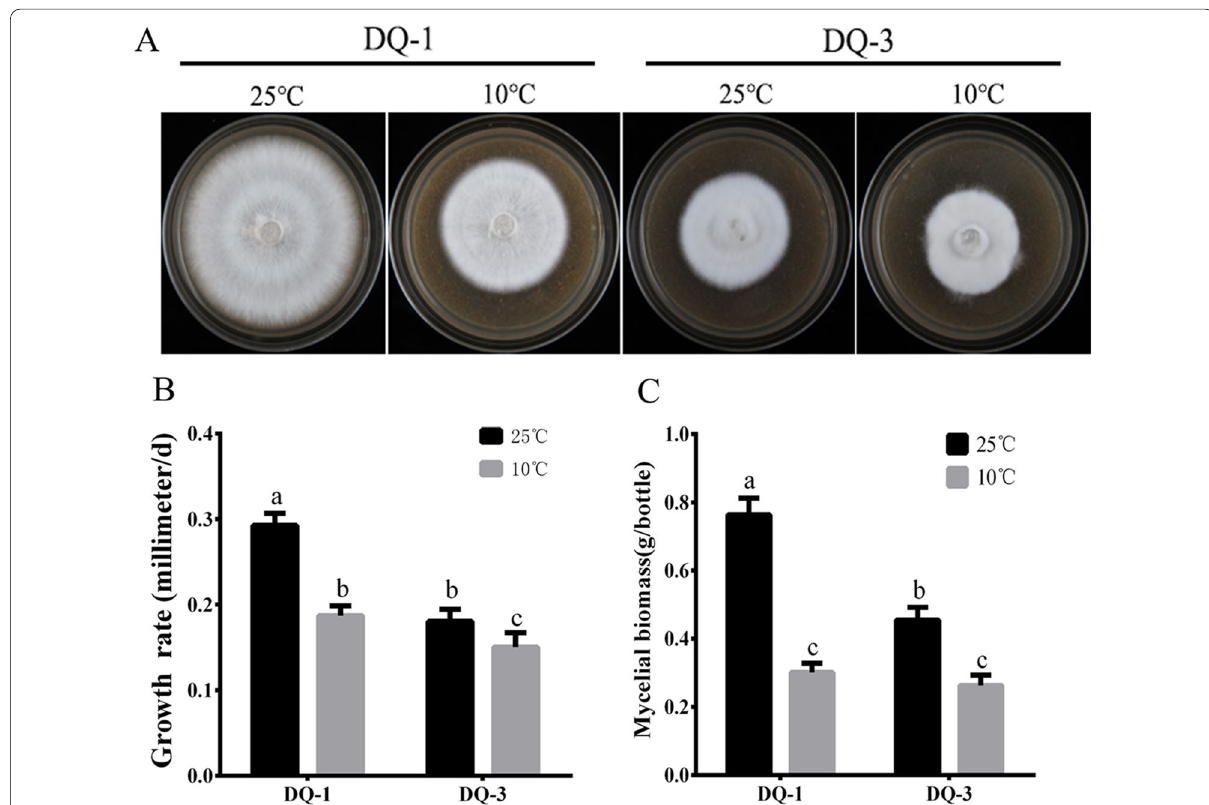
Fig. 1 Physiological performance of the S. rugosoannulata DQ-1 and DQ-3 strains under the different temperature treatments. A and B Mycelial growth state and growth rate of the DQ-1 and DQ-3 strains after treatment at 25 °C and 10 °C. C Mycelial biomass of strains DQ-1 and DQ-3 after treatment at 25 °C and 10 °C. The error bars represent the means standard deviations of triplicate ±